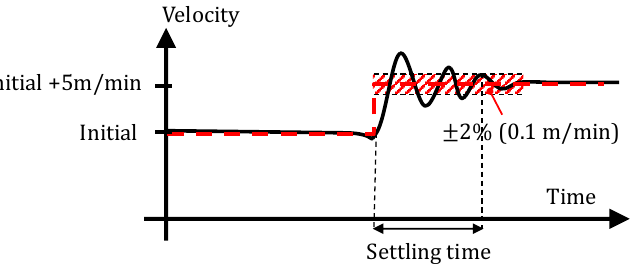
Figure 9. Description of the test for the settling time.